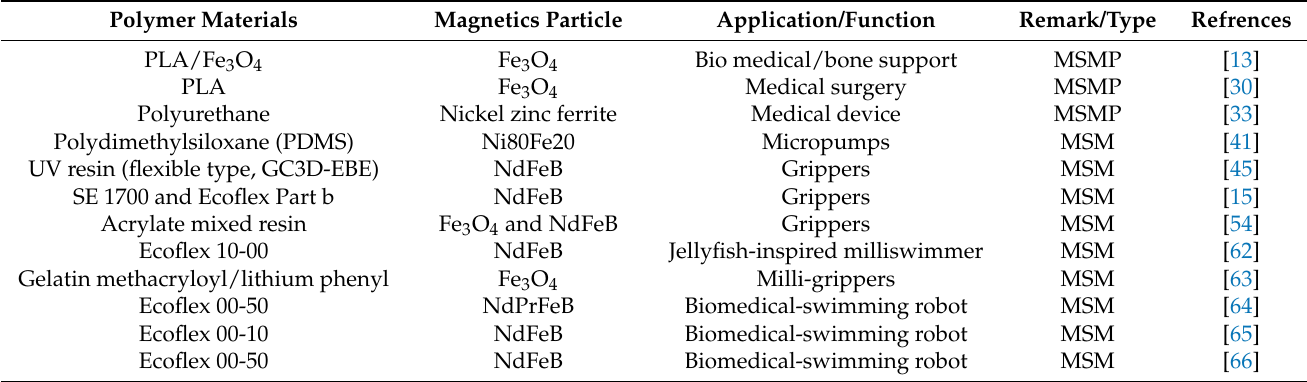
Table 4. Summarized applications for MSMPs and